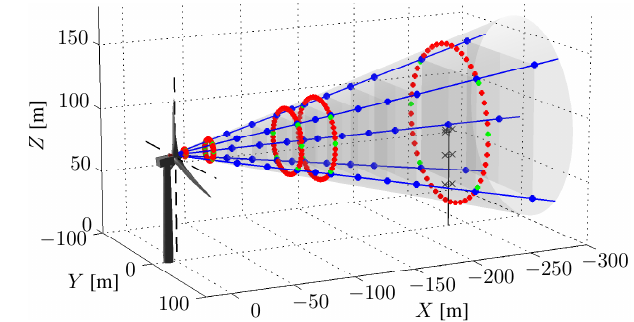
Figure 5. Lidar measurement trajectories in NKE. In blue: five- beam Avent Demonstrator. In red and green: ZephIR Dual Mode, the 48 azimuth-averaged LOS (red), including the 6 LOS (green) considered in the reconstruction cases of this